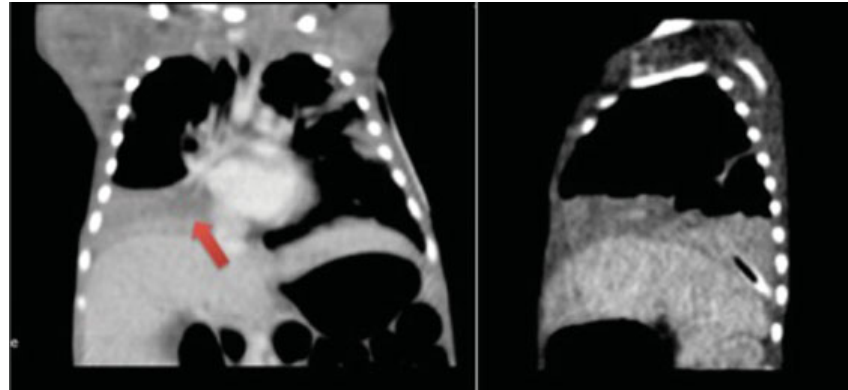
Fig. 2 Computed tomography of the chest (coronal and sagittal). Arrow on the chest X-ray indicates the foreign body at the hemithorax.